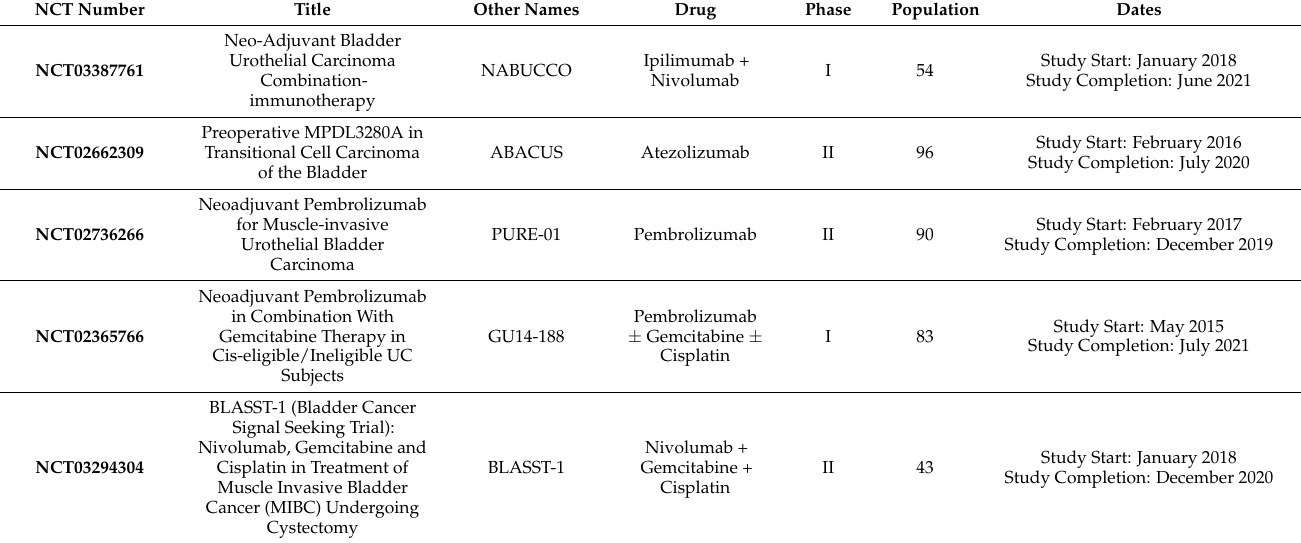
Table 3. Summary of published clinical